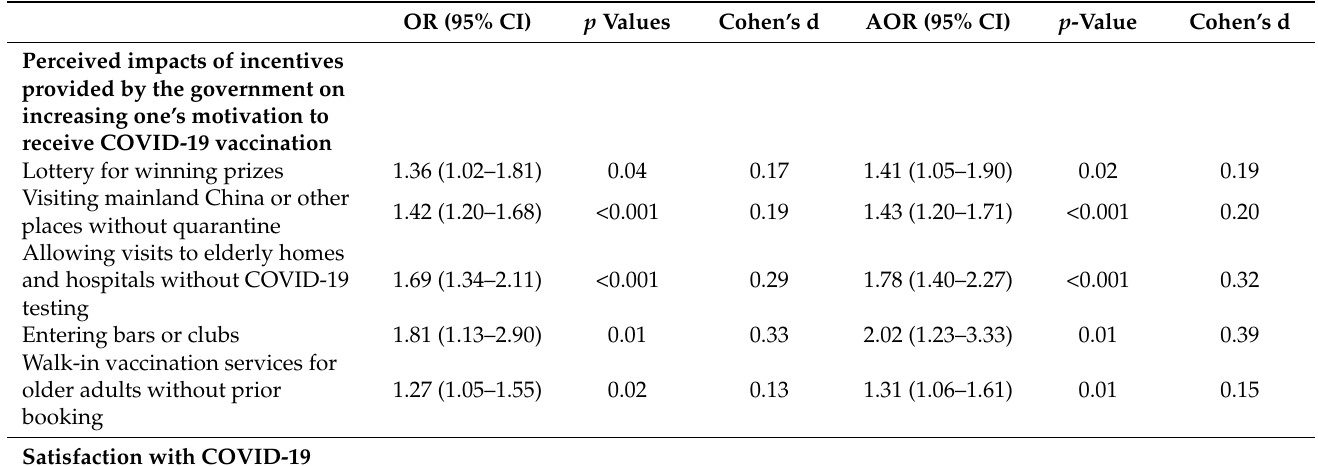
Table 4. Factors associated with completion of primary COVID-19 vaccination series among older adults in Hong Kong (n =